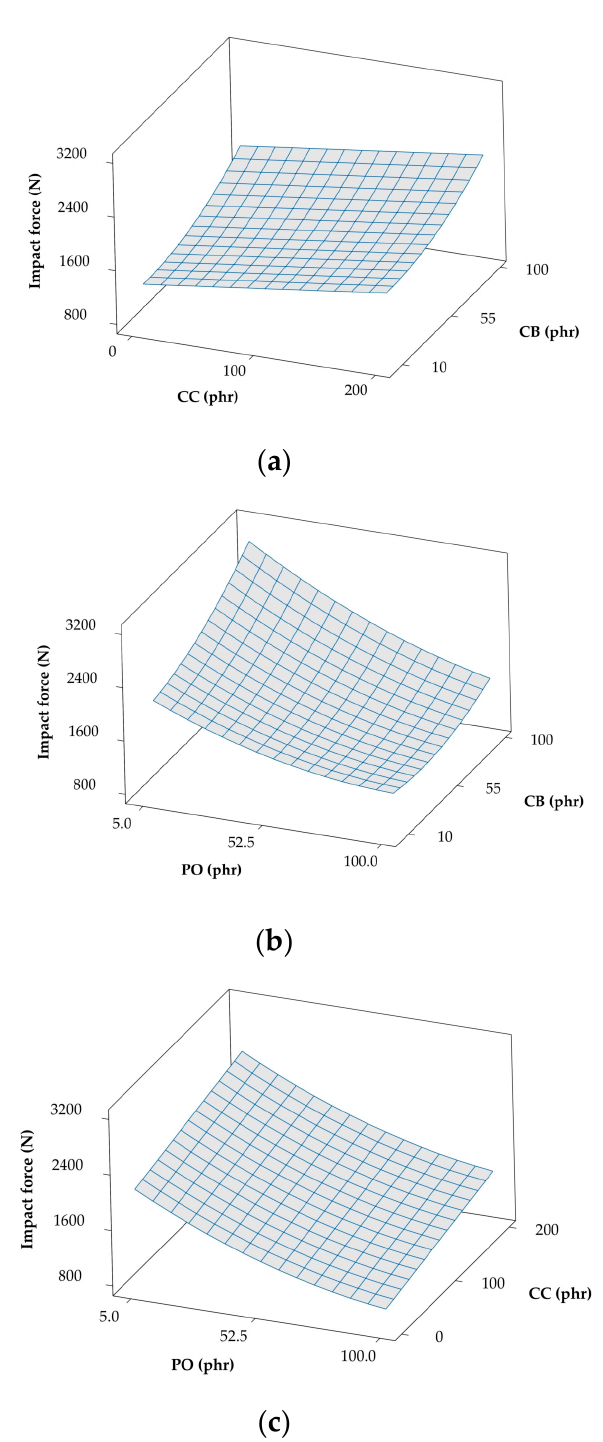
Figure 4. Response cross-correlation surface plots of impact force evaluated at 3 J with various combinations of additives: ( a ) CC and CB (PO held constant at 52.5), ( b ) PO and CB (CC held constant at 100), and ( c ) PO and CC (CB held constant at 55).